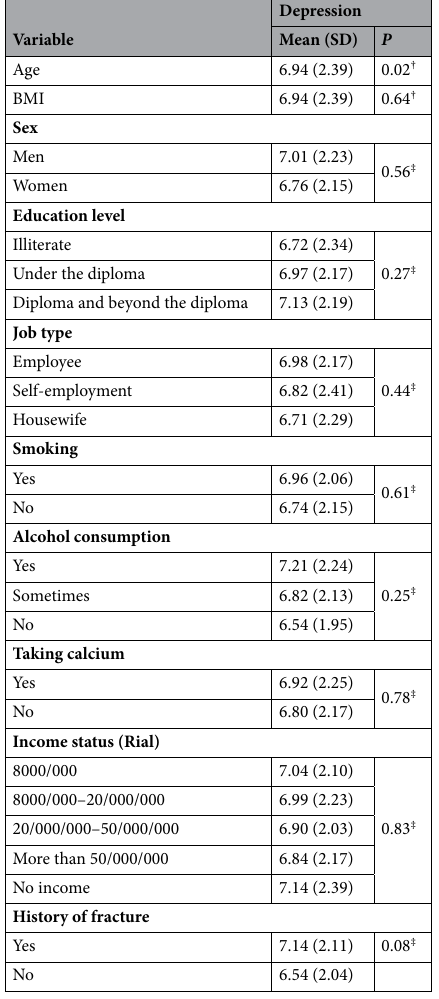
Table 3. Demographic characteristics of osteoporosis patients and their associations with the depression (n = 250). BMI body mass index, SD standard deviation. † Pearson correlation coefficient. ‡ Independent t test. ‡ One-way analysis of